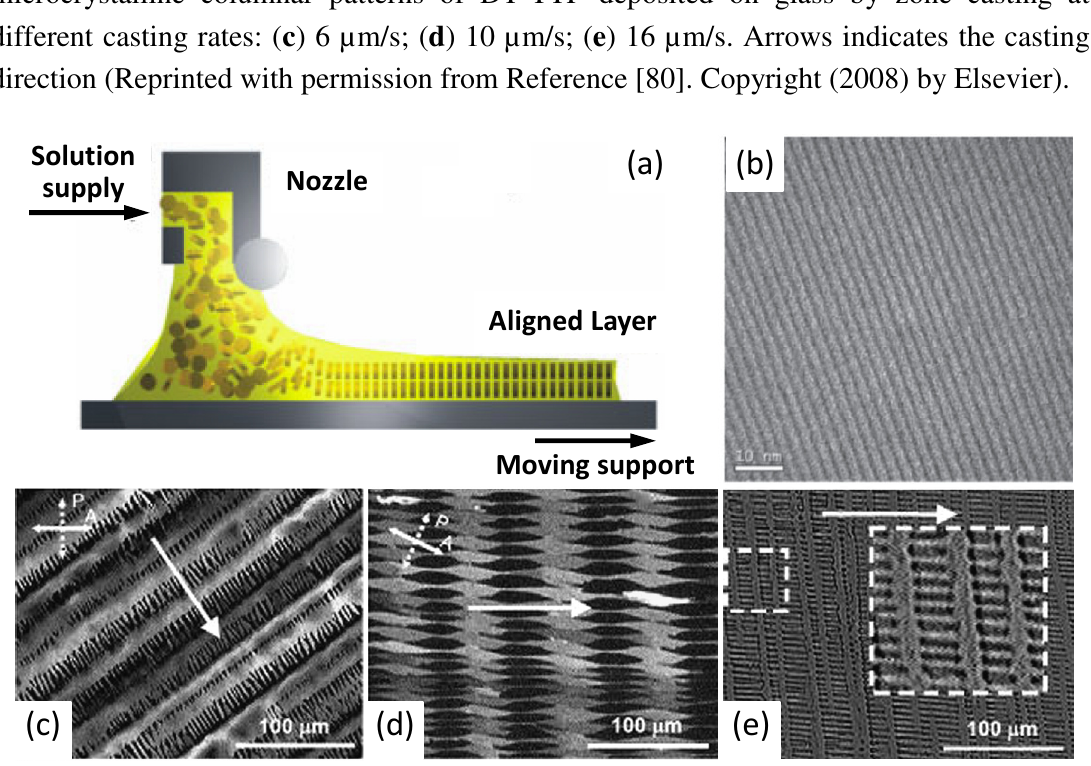
Figure 9. ( a ) Schematic representation of the zone-casting deposition method; ( b ) TEM large-area microgragh of a linear pattern. (Reprinted with permission from Reference